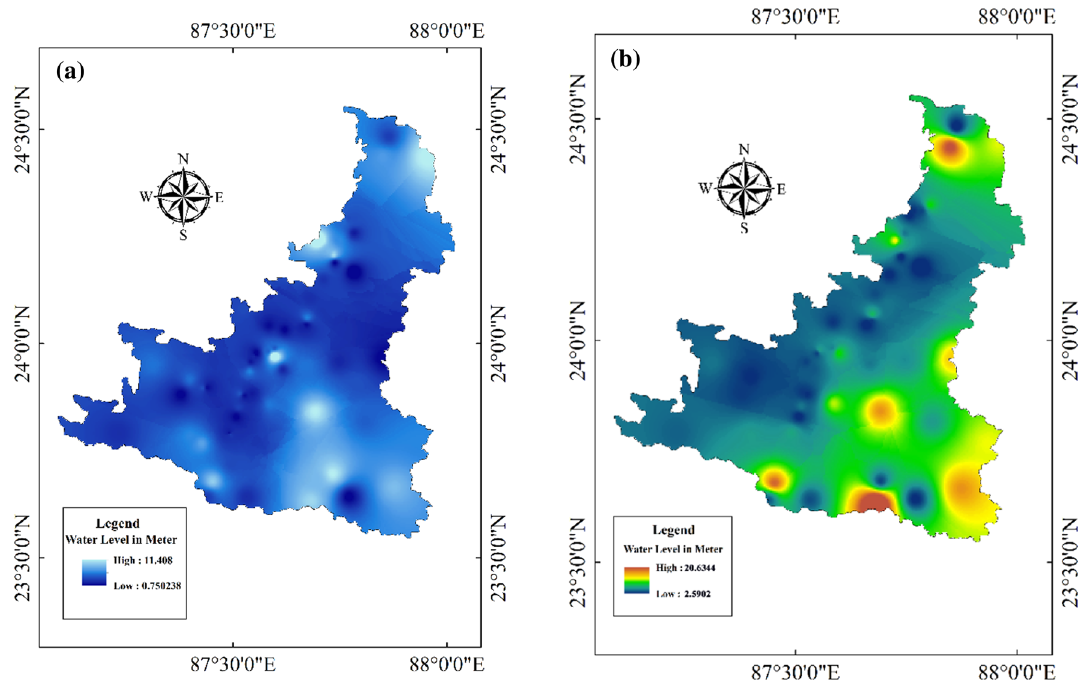
Fig. 11 Post-monsoon groundwater level in 1996 and 2019